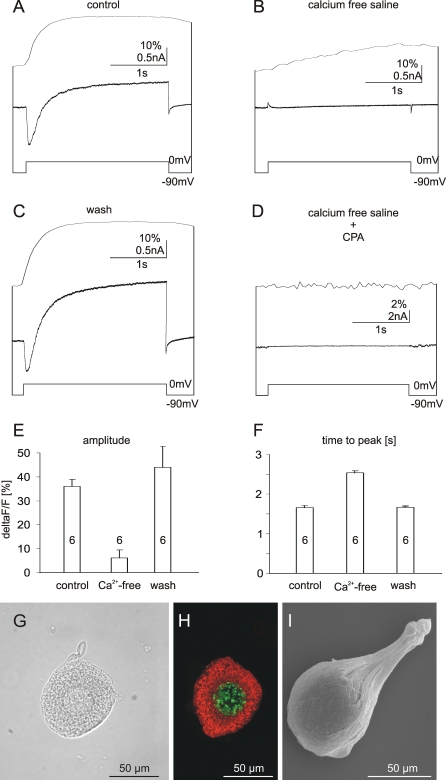
Voltage-Induced Intracellular Calcium Signals Occur in the Absence of Calcium Inward Current(A–C) Simultaneous patch clamp recording (lower traces) and calcium imaging (upper traces) from a representative, acutely isolated DUM neuron under different conditions. (A) In TEA- and TTX-containing saline, a voltage step from −90 mV holding to 0 mV test potential causes a calcium inward current followed by a calcium-activated potassium outward current. This is accompanied by a large elevation in internal calcium. (B) No membrane currents are observed in the same neuron after 3 min in calcium-free saline, but a slow elevation in intracellular calcium occurs in response to a similar voltage step as in (A). (C) Switching back to calcium-containing extracellular saline restores membrane currents and intracellular calcium signals as observed in (A).(D) Following depletion of intracellular calcium stores by extracellular application of CPA, no calcium elevation is recorded in zero-calcium saline in response to the step depolarization.(E and F) Average amplitudes (E) and average times to peak (F) of the calcium signals are shown for six neurons (mean and standard deviation) that were recorded continuously in calcium-containing control saline (left bars), zero-calcium saline (middle bars), and calcium-containing saline (right bars).(G) Photograph of a representative neuron just prior to recording demonstrates that isolated neurons are not in contact with each other or with neighboring glia cells.(H) This lack of contact is further supported by immunocytochemical labeling of the same neuron after the physiological experiments. Anti HRP (red) is used as a general neuronal marker, and a DNA stain (propidium iodide and RNAse [green]; see Materials and Methods) is used to depict nuclei. No nuclei of glia cells or neurons are detected in proximity to the recorded neuron.(I) SEM picture of a recorded soma with its primary neurite shows no contact with other neighboring cells.